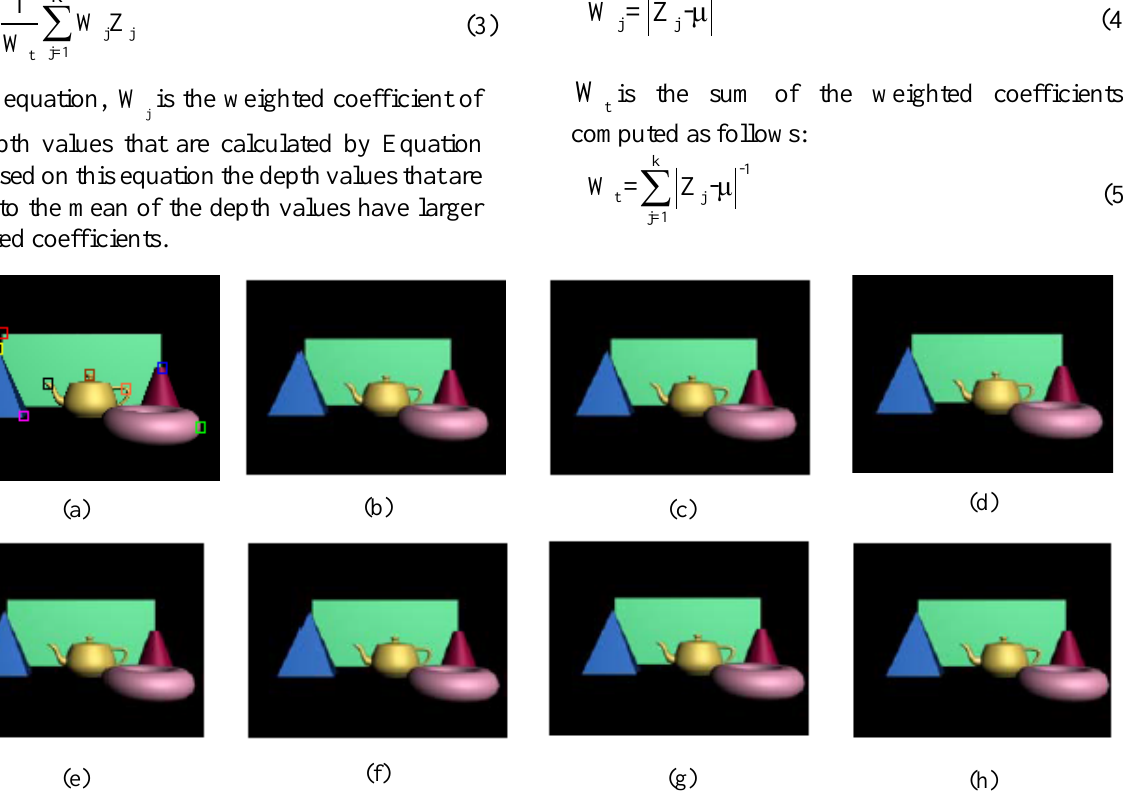
Figure 3. Different views of "Collection".